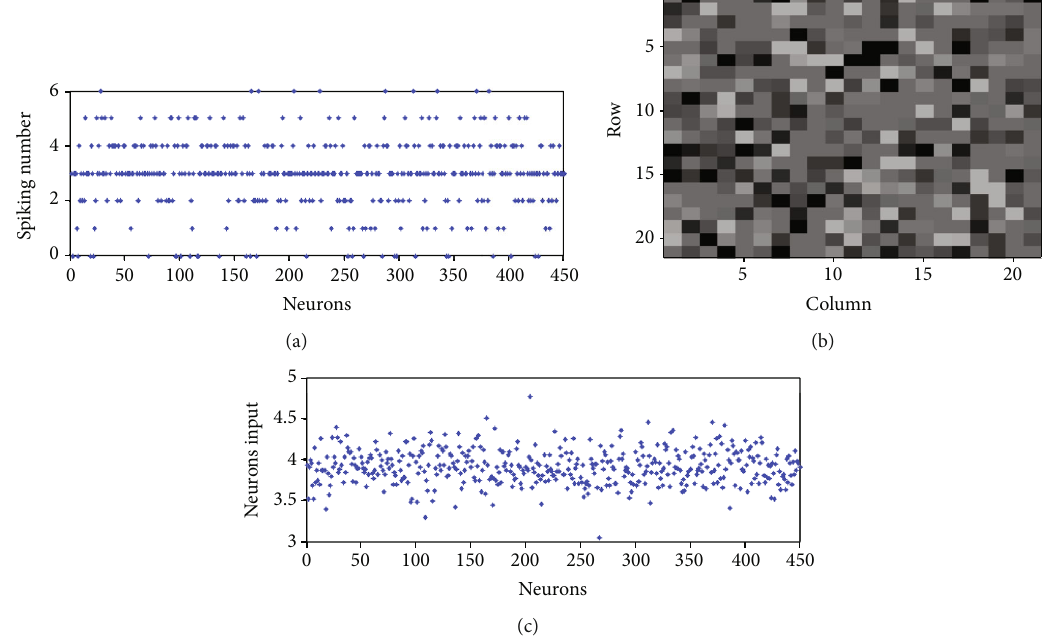
Figure 3: Firing rates of all excitatory neurons in E/I networks with no noise, σ S 300ms; (b) visualization of the fi ring rates of neurons 1-400 with gray values located at ( i , j ) representing the fi ring rate of neurons 20 ∗ ð i − 1 Þ + j ; (c) inputs of neurons 1-450.